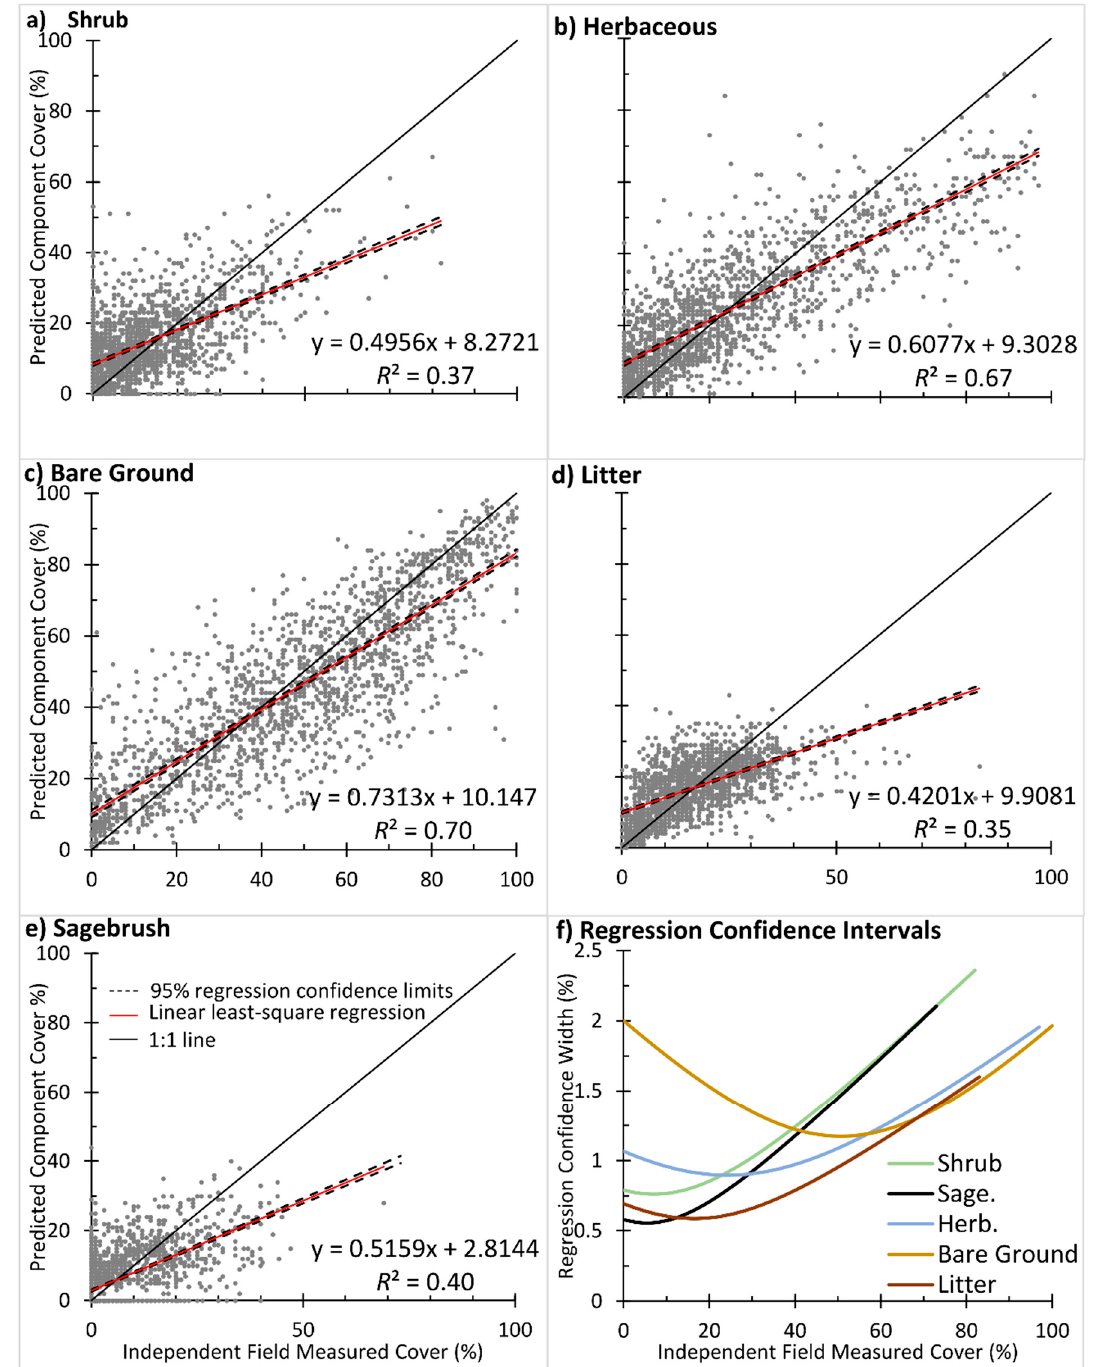
Figure 8. Independent accuracy scatterplots ( n = 1860) and 95% regression confidence limits for field measured versus predicted cover of selected components: ( a ) shrub, ( b ) herbaceous, ( c ) bare ground, ( d ) litter, and ( e ) sagebrush cover. ( f ) Width of 95% regression confidence limits (upper limits minus